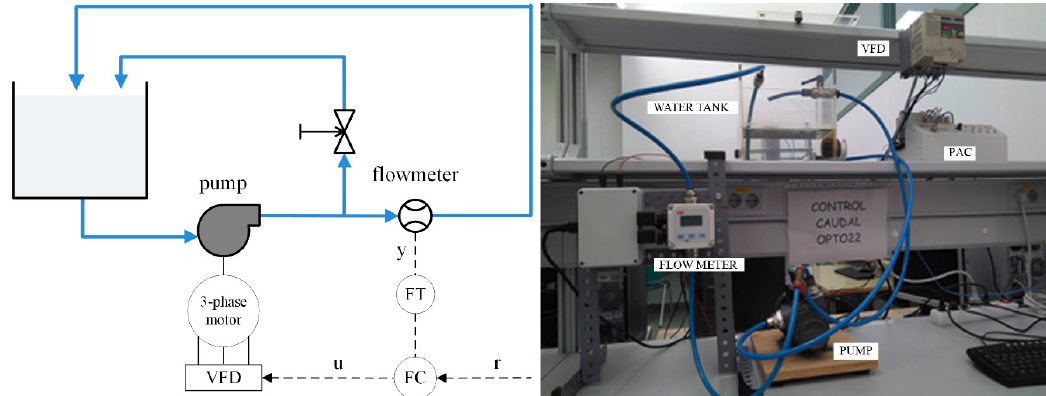
Figure 10. Schematic of the plant and experimental setup.